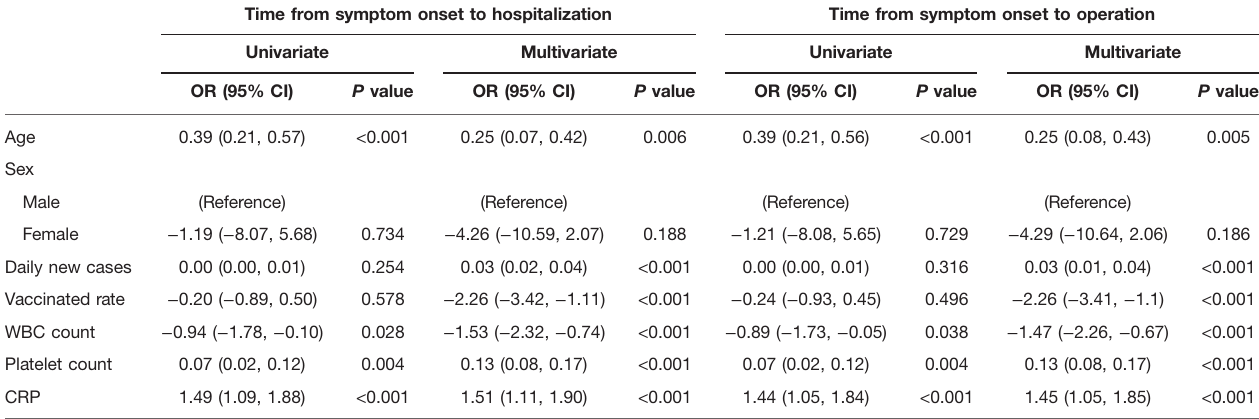
TABLE 4 | Linear regression for time from symptom onset to hospitalization and time from symptom onset to